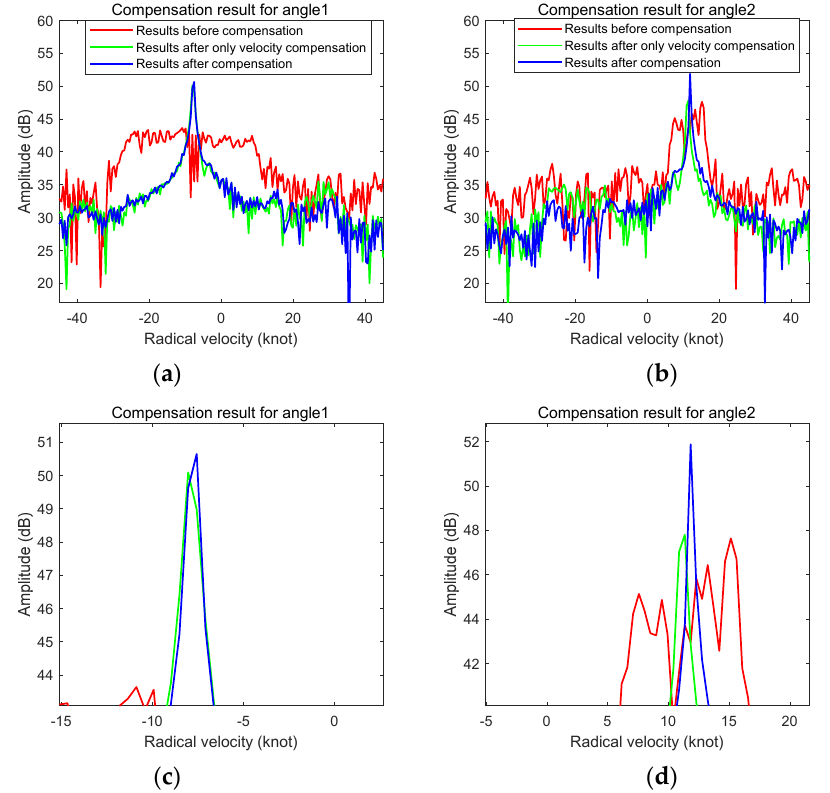
Figure 18. Compensation result for case of uniform deceleration motion: ( a ) compensation result for angle1, ( b ) compensation result for angle2, ( c ) zoom in of peak for target 1, ( d ) zoom in of peak for target 2.